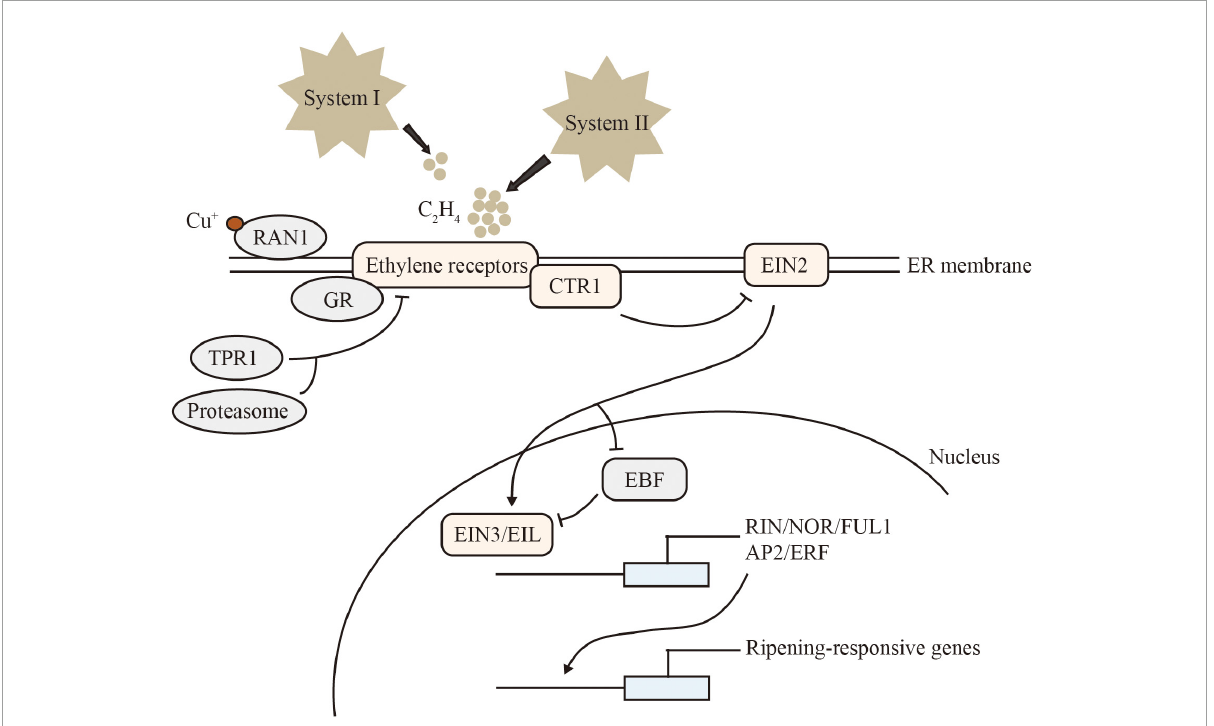
FIGURE1 Model of ethylene signaling. CTR1 is a serine/threonine protein kinase that directly phosphorylates and inhibits EIN2 in the absence of ethylene. EIN2 contains multiple transmembrane domains at its N terminus and a cytoplasmic C terminus. In the presence of ethylene, the EIN2 C-terminal domain is cleaved and translocated into the nucleus. ETHYLENE INSENSITIVE3 BINDING F-BOX (EBF) proteins are responsible for targeting and degrading EIN3/EIL. EIN2 binds to and leads to the degradation of mRNAs encoding EBF1 and EBF2. In addition, EIN2 can regulate EIN3-dependent transcription. The accumulation and stabilization of EIN3/EIL lead to numerous transcriptional changes. Arrows represent activation, T-bars indicate